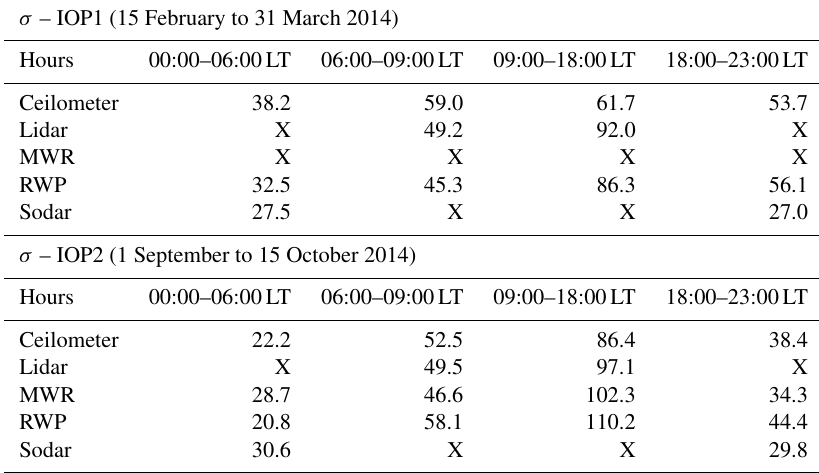
Table 2. Standard deviation calculated for PBL height measurements of instruments at different intervals of the daily cycle. σ – IOP1 (15 February to 31 March